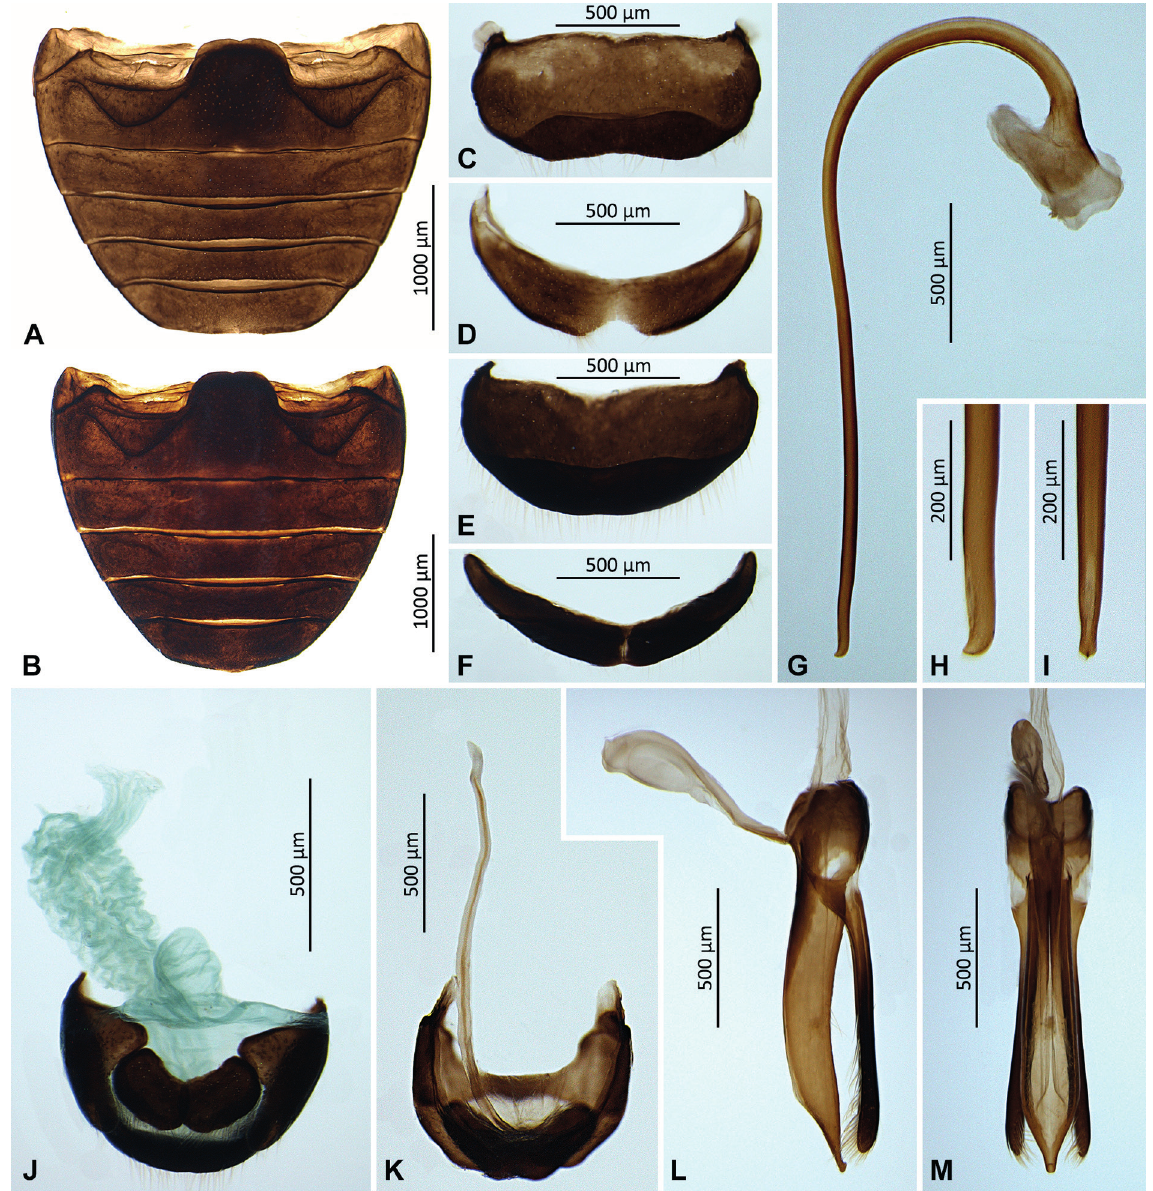
Fig. 12. Toxotoma gonzalezi sp. nov. A . Holotype (MNHW), ♂, abdomen. B . Paratype (MNHW), ♀, abdomen. C . Holotype (MNHW), ♂, tergite VIII. D . Holotype (MNHW), ♂, ventrite 6. E . Paratype (MNHW), ♀, tergite VIII. F . Paratype (MNHW), ♀, ventrite 6. G . Holotype (MNHW), penis, lateral view. H . Holotype (MNHW), penis tip, lateral view. I . Holotype (MNHW), penis tip, inner view. J . Paratype (MNHW), ♀ genitalia, ventral view. K . Holotype (MNHW), ♂, segments IX and X, dorsal view. L . Holotype (MNHW), tegmen, lateral view. M . Holotype (MNHW), tegmen, inner